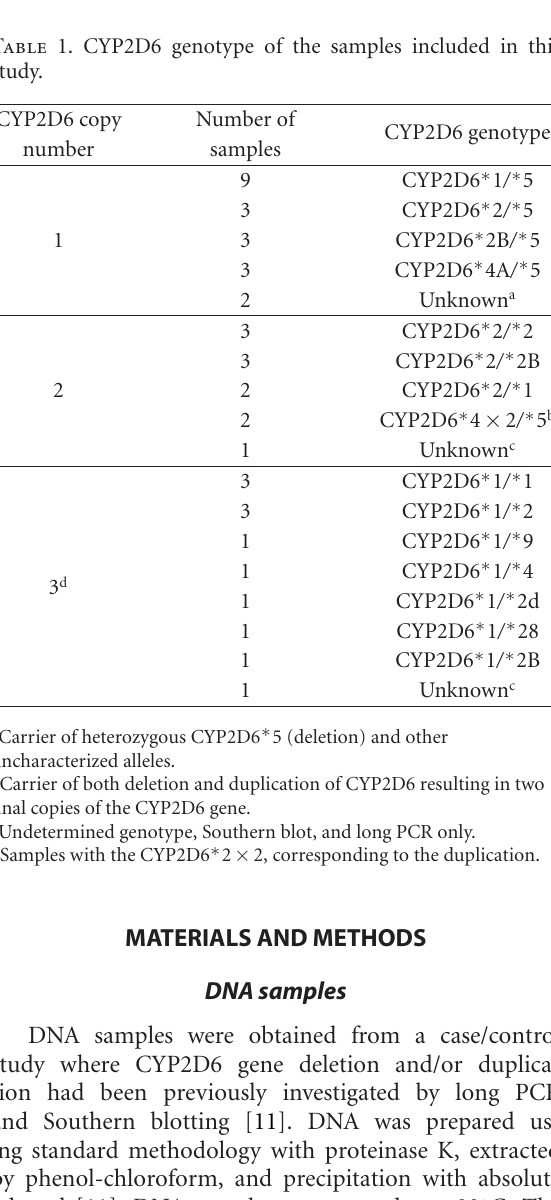
CYP2D6 genotype